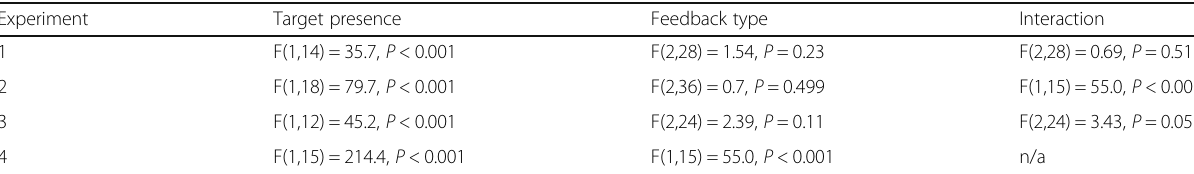
Table 3 Response time